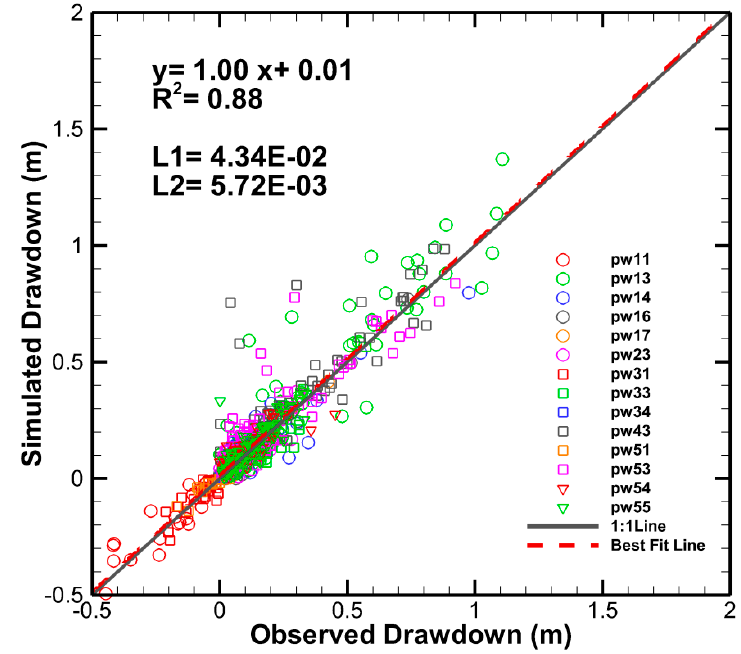
Figure 4. Calibration scatterplot of simulated versus observed drawdowns for THT analysis.